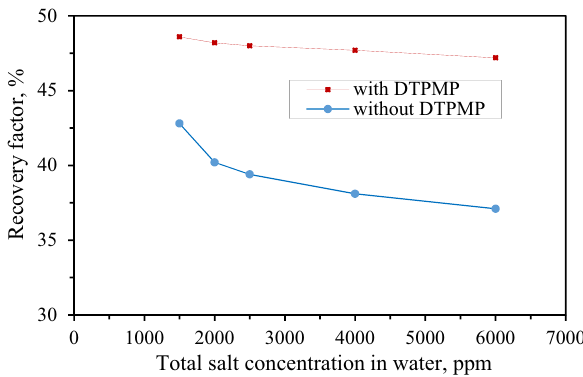
Fig. 6 The changes in recovery factor during LSWI at different salt concentrations with and without DTPMP (in the absence of nanopar- ticles)